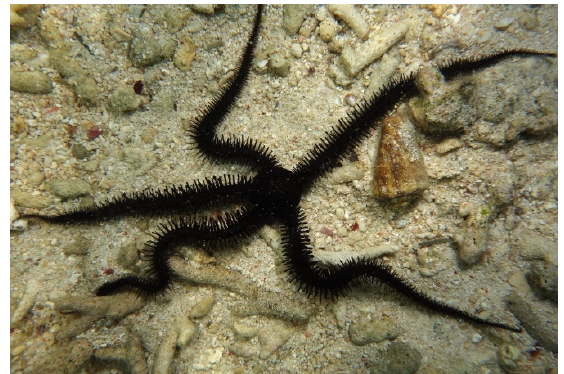
Figure 27. An individual of Ophiocoma erinaceus . © Patrick Randall (CC BY-NC-SA 2.0); https://www.flickr.com/.